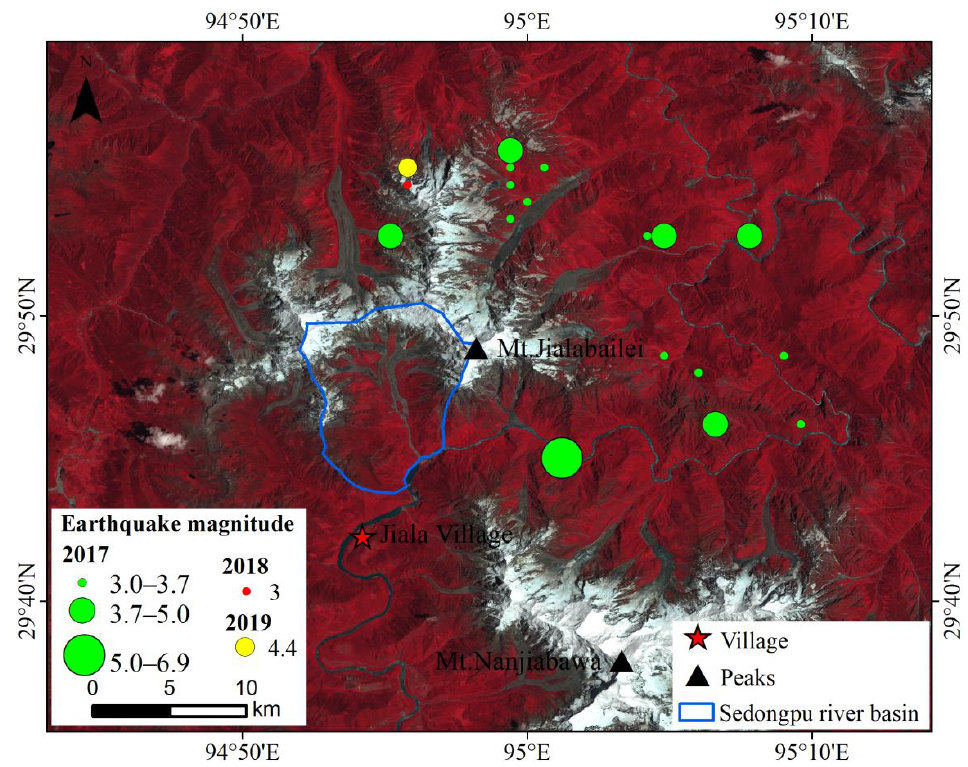
Figure 8. Distribution of earthquakes during the 2017 – 2019 period in Sedongpu basin and surround- ing regions; the background image is Sentinel-2 in 2018.